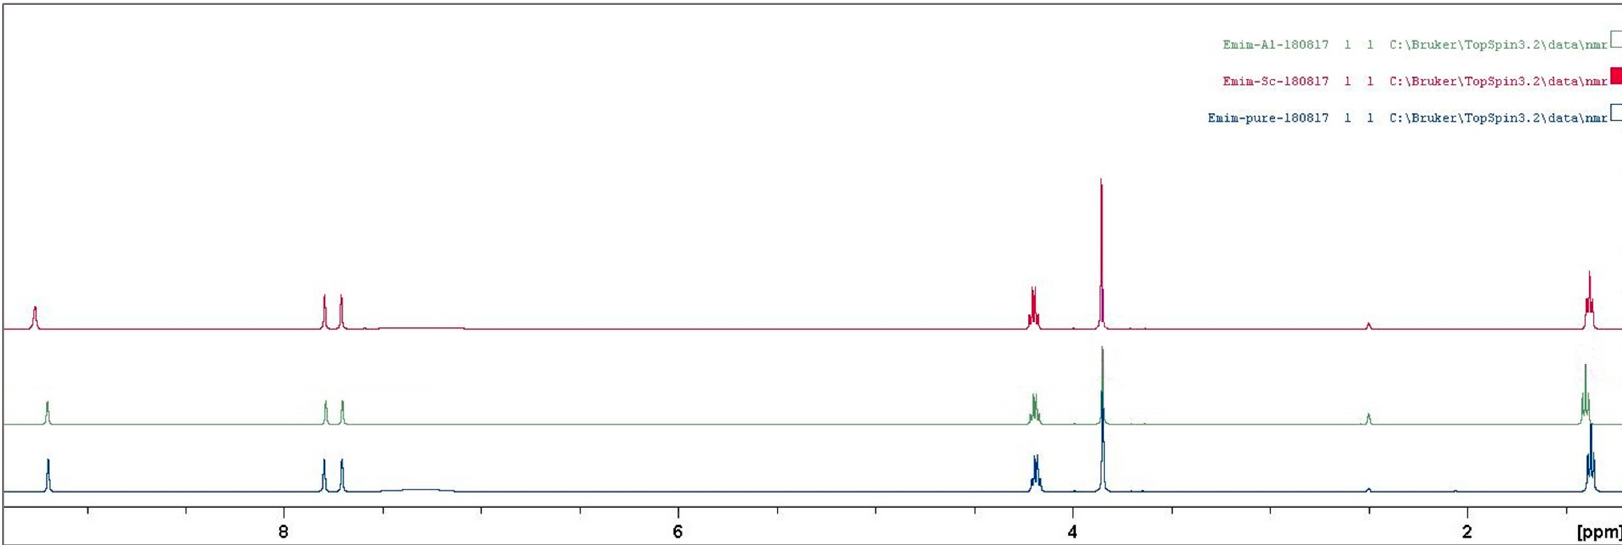
Figure A1. 1 H Nuclear Magnetic Resonance (NMR) comparison between [Emim][HSO 4 ] (blue), [Emim][HSO 4 ] after leaching Al 2 O 3 (green), [Emim][HSO 4 ] after leaching Sc 2 O 3 (red).